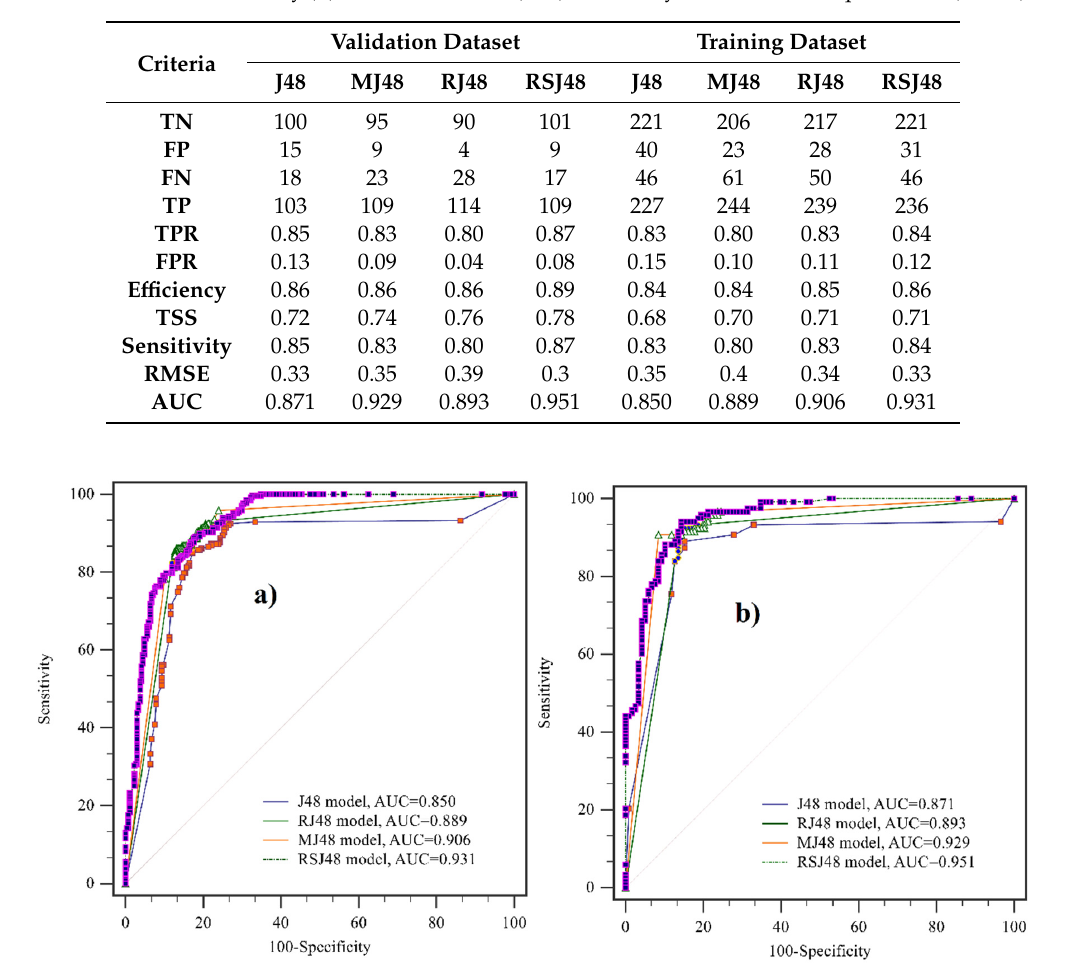
Figure 7. Receiver operating characteristic (ROC) curves representing the accuracy of the flood susceptibility models ( a ) training dataset (success rate curve), ( b ) validation dataset (prediction rate curve).